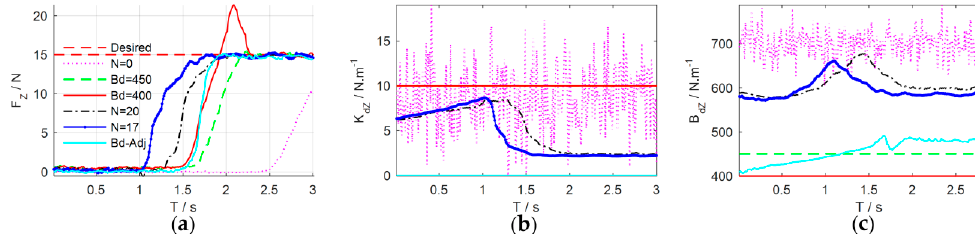
Figure 20. Experimental comparison results. ( a ) Force control performance; ( b ) target stiffness; ( c ) target damping.